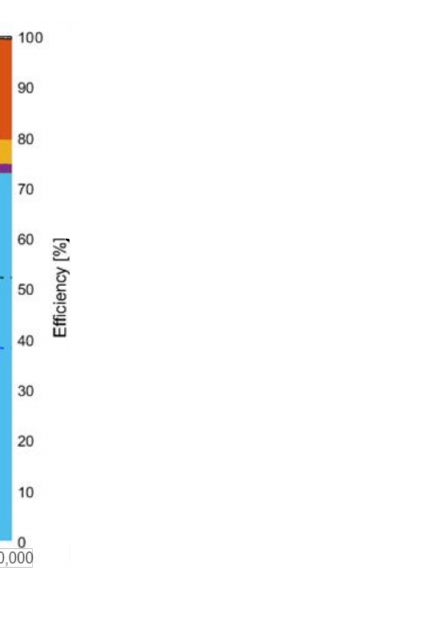
Figure 8. Warm-up simulation: time profile of gross power generations, power internal consumptions and net power generation (left axis) and gross stack and net system efficiency (right axis). Table 3. Water content (inventory) in the main plant component for the base case and cases A, B, and C of the sensitivity